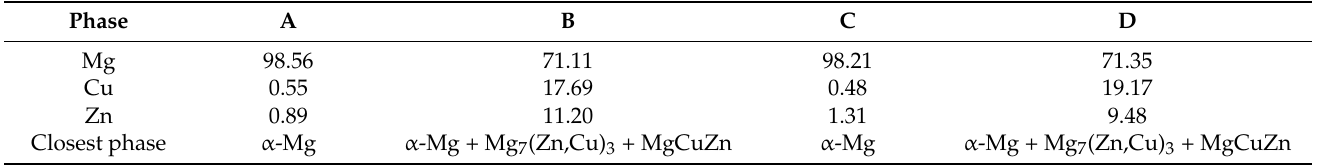
Table 1. Composition of the intermetallic phases of 4 regions in Figure